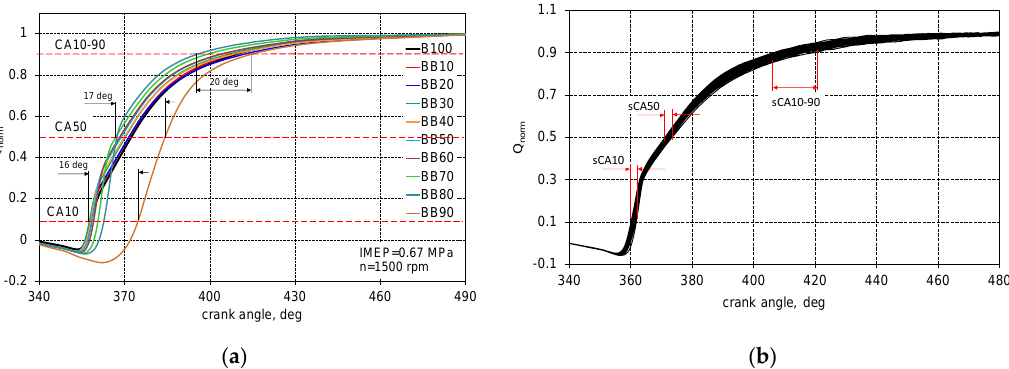
-0.200.20.40.60.81 Energies 2021 , 14 , x FOR PEER REVIEW Figure 9. Normalized heat release and combustion stages ( a ) and the spread of the characteristic stages of combustion ( b ). Figure 10. Combustion stages ( a ) and spread of combustion stages ( b ).